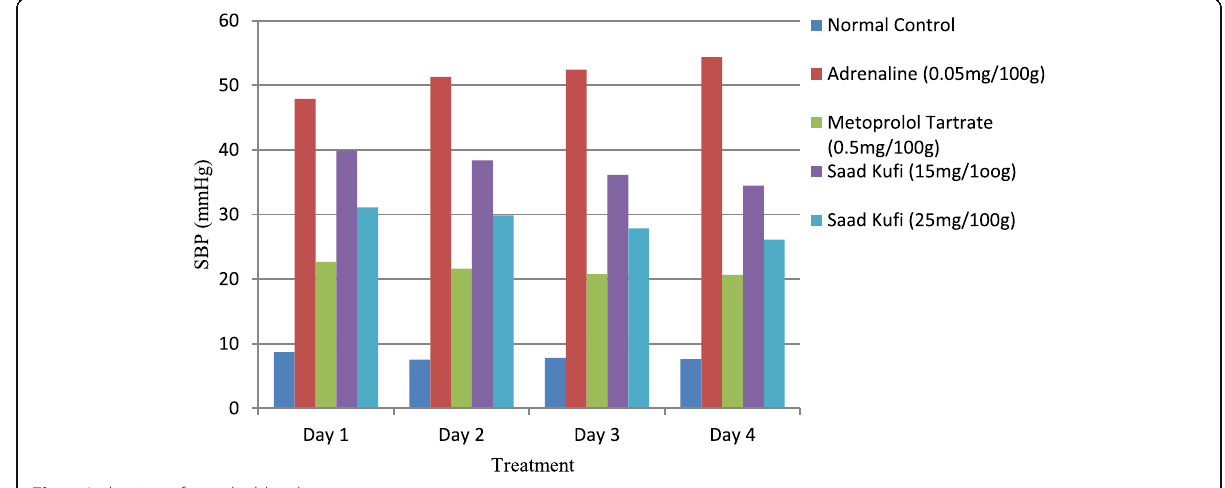
Fig. 1 Induction of systolic blood